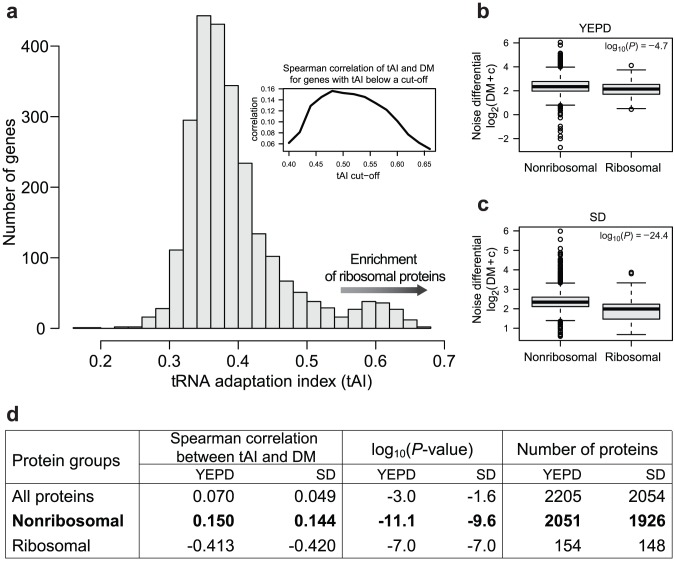
(a) Histograms of tRNA adaptation index (tAI) scores of budding yeast genes shows a long tail of high tAI values that is highly enriched in ribosomal genes (98 out of 153 genes with tAI>0.55, binomial test p-value<e-74). Inset: Spearman correlation between tAI and DM increases at a wide range of high tAI cut-off values. (b,c) Ribosomal and nonribosomal genes have different distributions of noise differentials (DM) in both YEPD and SD media – the ribosomal genes are significantly less noisy. For graphing purpose the DM values are shifted by constant c = 5 prior taking the logarithm. (d) Spearman correlation between tAI and noise differential (DM) for the whole dataset, including nonribosomal and ribosomal proteins in YEPD and SD media.